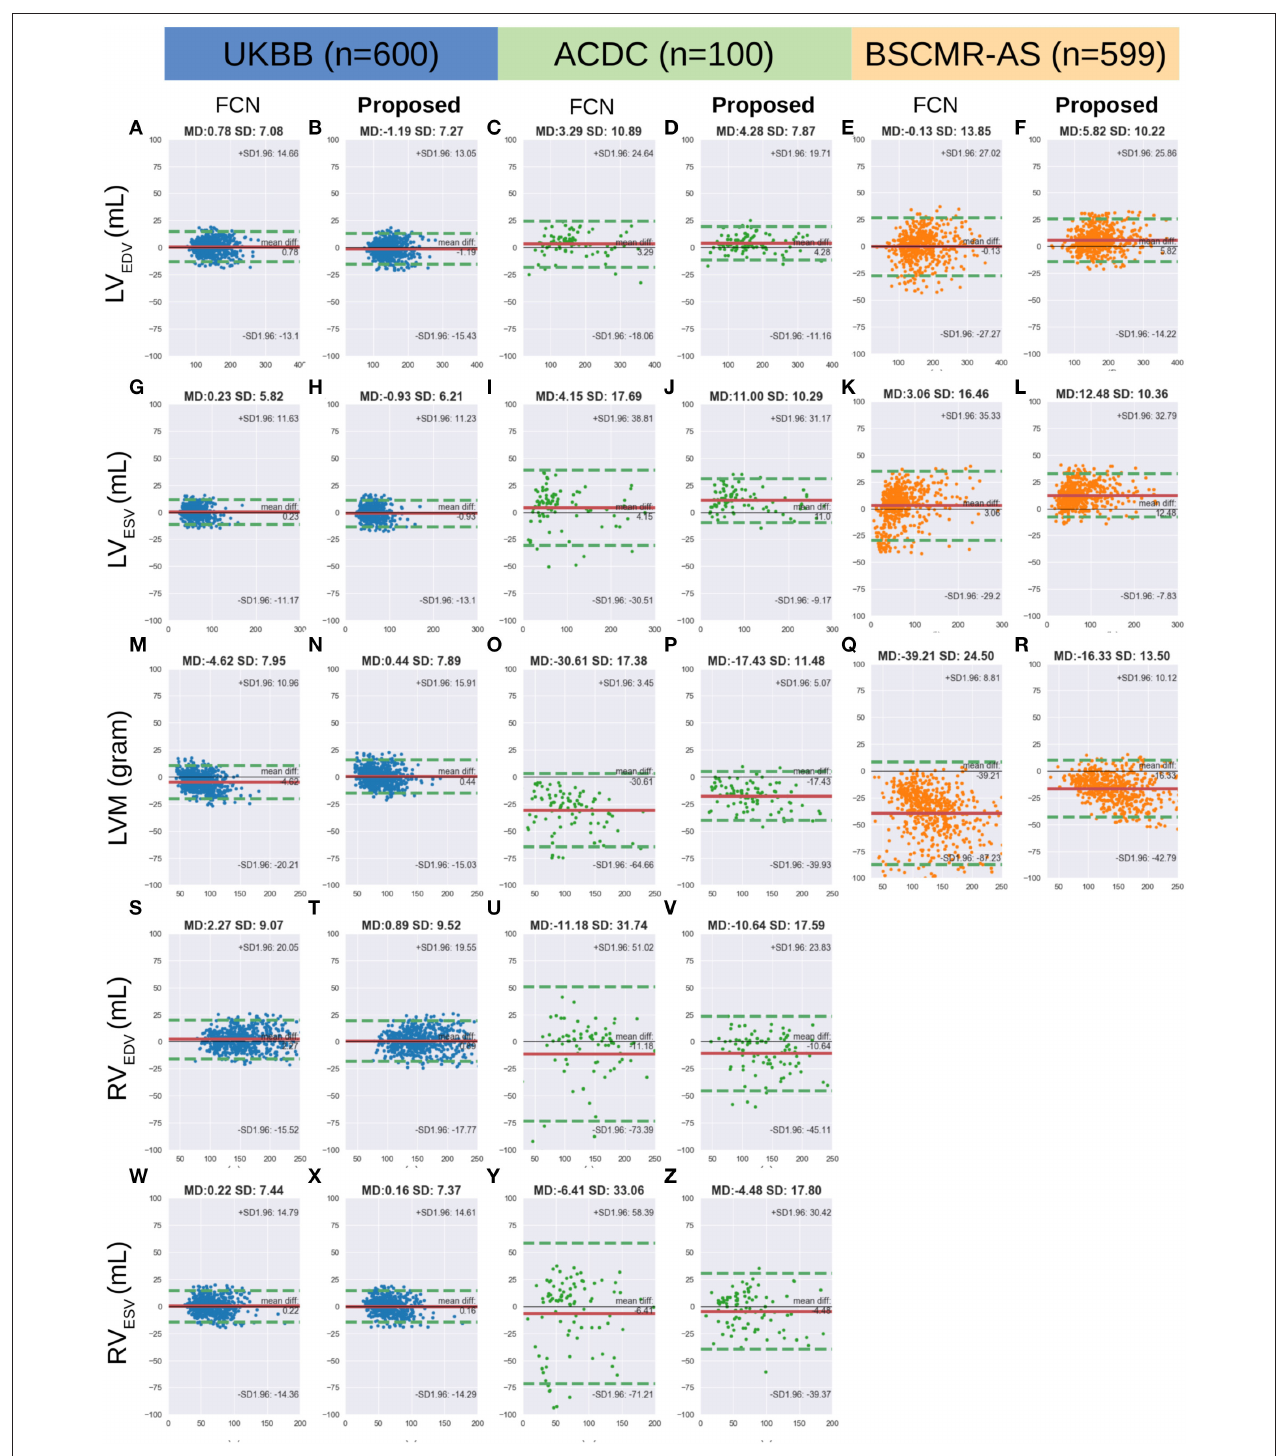
FIGURE 6 | (A-Z) are Bland Altman plots (automatic-manual) for the three datasets. Agreement of clinical measurement from automatic and manual segmentations. Bland Altman plots (automatic-manual) are shown regarding the three sets. In each Bland-Altman plot, the x-axis denotes the average of two measurements whereas the y-axis denotes the difference between them. The solid line in red denotes the mean difference (bias) and the two dashed lines in green denote ± 1.96 standard deviations from the mean. The title of each plot shows the mean difference (MD) and its standard deviation (SD) for each pair of measurements. FCN, the automatic method in our previous work (3); LV/RV, left/right ventricle; EDV/ESV, end-diastolic/systolic volume; LVM, left ventricular mass.